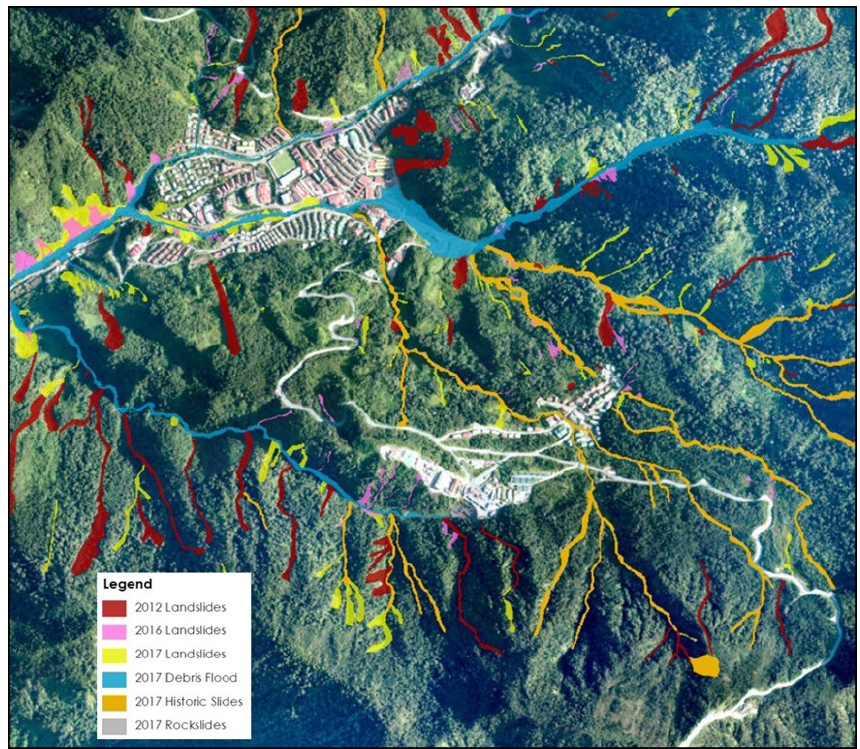
Figure 8. An historical inventory revealed 375 landslides, primarily debris flows, in the slopes surrounding Tembagapura. Years refer to the year of imagery and the background image is a vertical air photograph obtained by the authors.